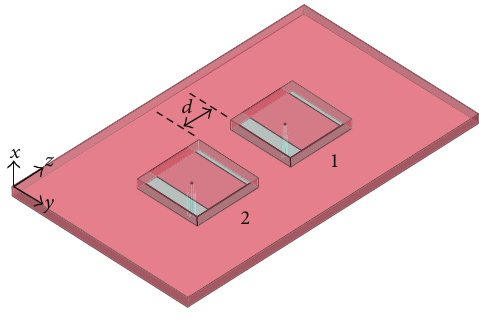
Figure 16: Collinear array of CBHM antennas.